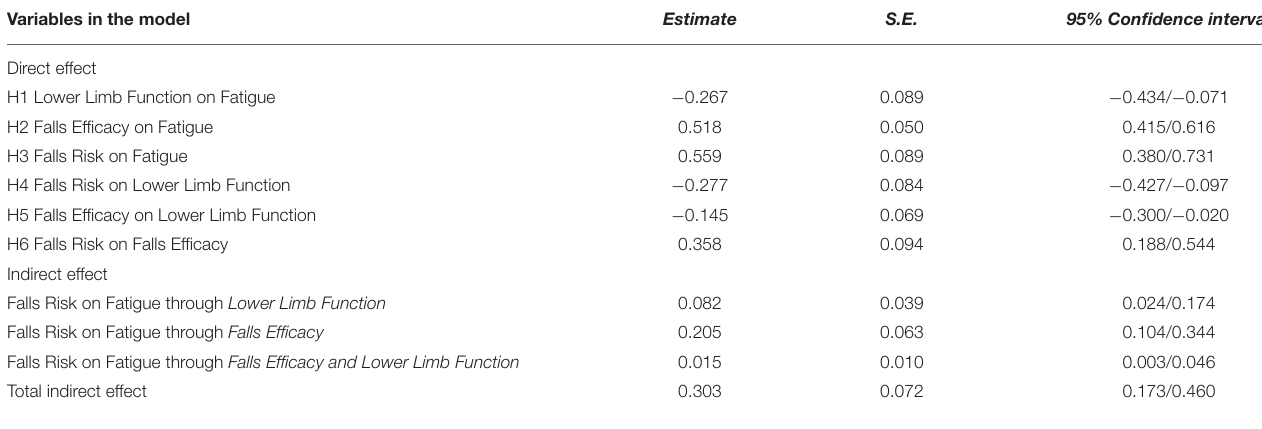
TABLE 3 | Decomposition of Effects of Variables in Structural Equation Modeling ( N =